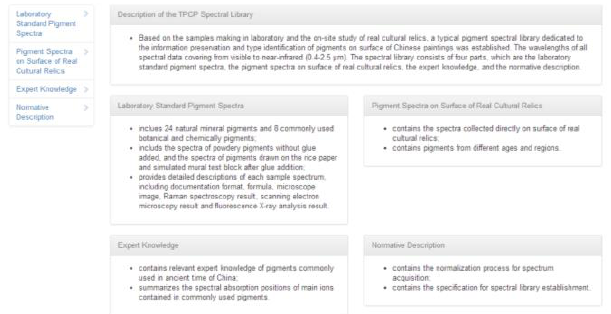
Figure 7. The home page of TPCP spectral library